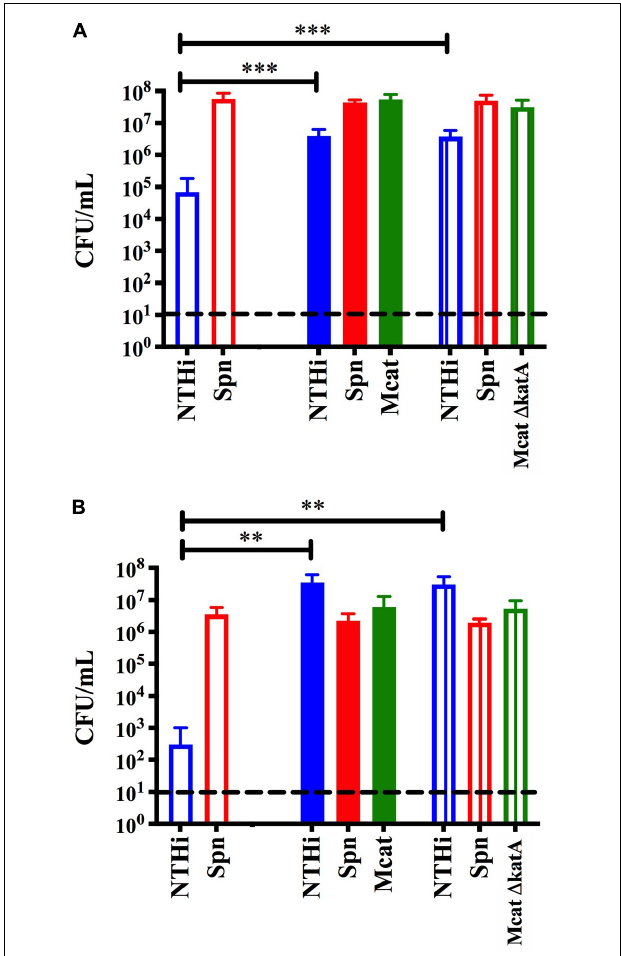
FIGURE 5 | Transwell assay to assess the protective capacity of a M. catarrhalis catalase mutant. Dual species S. pneumoniae (SpnEF3030) and NTHi 86-028 NP (NTHi86028) biofilms were seeded in 24-well plates on a fixed H292 cell monolayer. To the transwell inserts, approximately 10 5 CFU per mL M. catarrhalis 7169 (solid), Mcat7169 (cid:49) katASpec1 (vertical stripes) or CDM (open) was added. Protection was assessed at (A) 24 h and statistical analysis was performed using a one-way ANOVA and Dunnett’s multiple comparison test of log transformed CFU per mL (B) and 48 h and statistical analysis was performed on log transformed CFU per mL using the Kruskal–Wallis with Dunn’s multiple comparison test. Bars represent the mean and standard deviation of three independent assays with a minimum of two technical replicates. P -value of < 0.01 denoted ∗∗ and P -value of < 0.001 denoted ∗∗∗